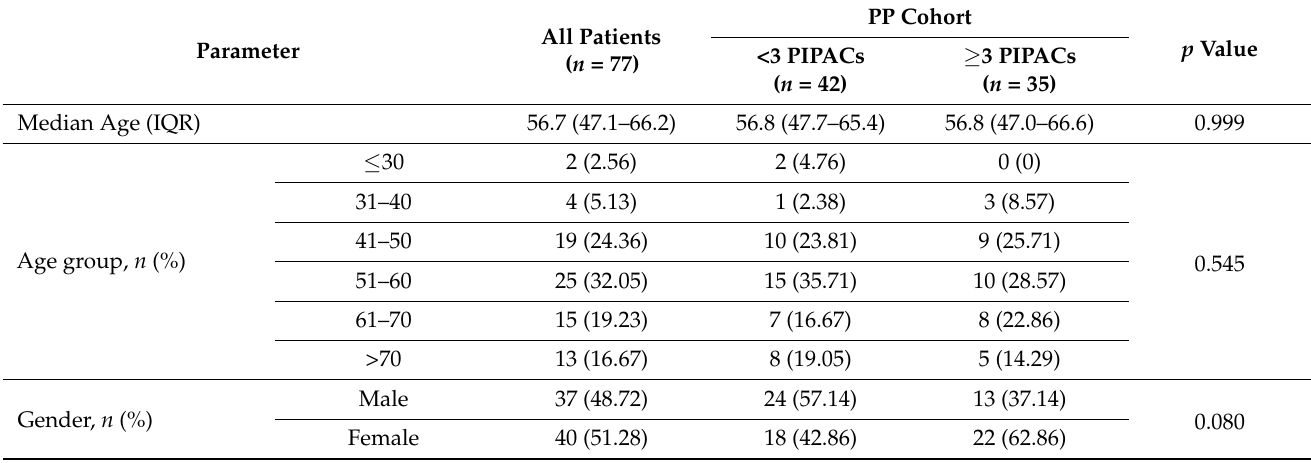
Figure 1. Flow chart of all patients undergoing PIPAC procedures. Causes of PIPAC treatment interruption are described precisely. PIPAC = Pressurized IntraPeritoneal Aerosol Chemotherapy; CRS = Cyto Reductive Surgery, HIPEC = Hyperthermic intraperitoneal chemotherapy; IP = intraperitoneal chemotherapy. Table 1. Baseline characteristics of patients undergoing Pressurized IntraPeritoneal Aerosol Chemotherapy for appendiceal peritoneal metastases.